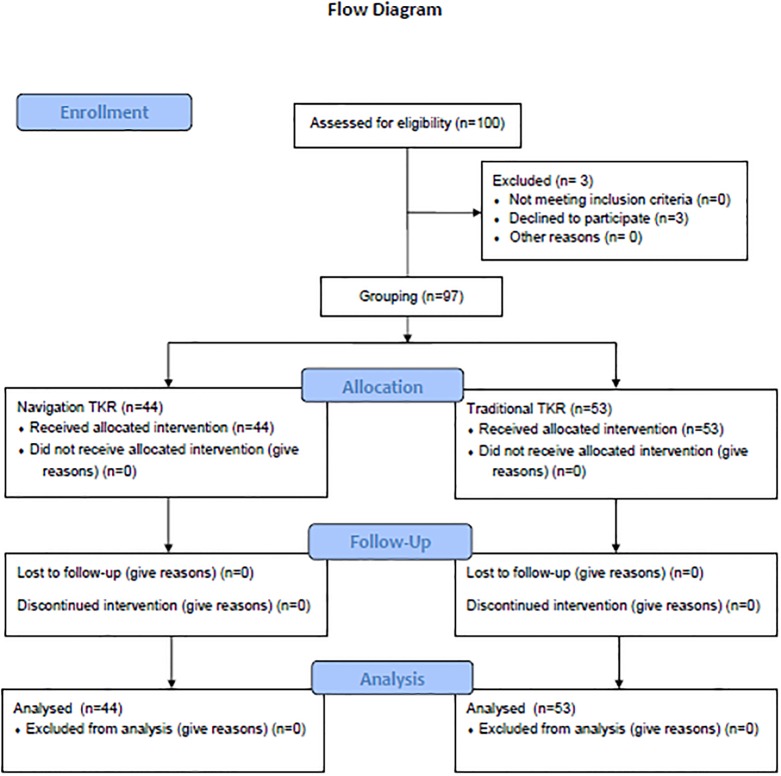
Flowchart of the participants at each stage of the study.